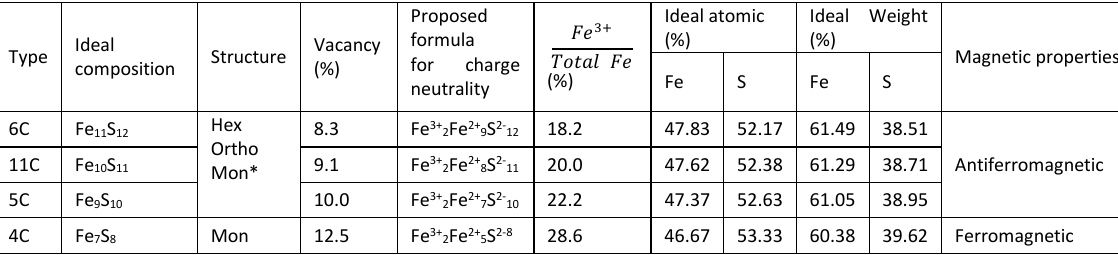
Table 1. Characteristic of naturally occurring pyrrhotite (modified from [27])